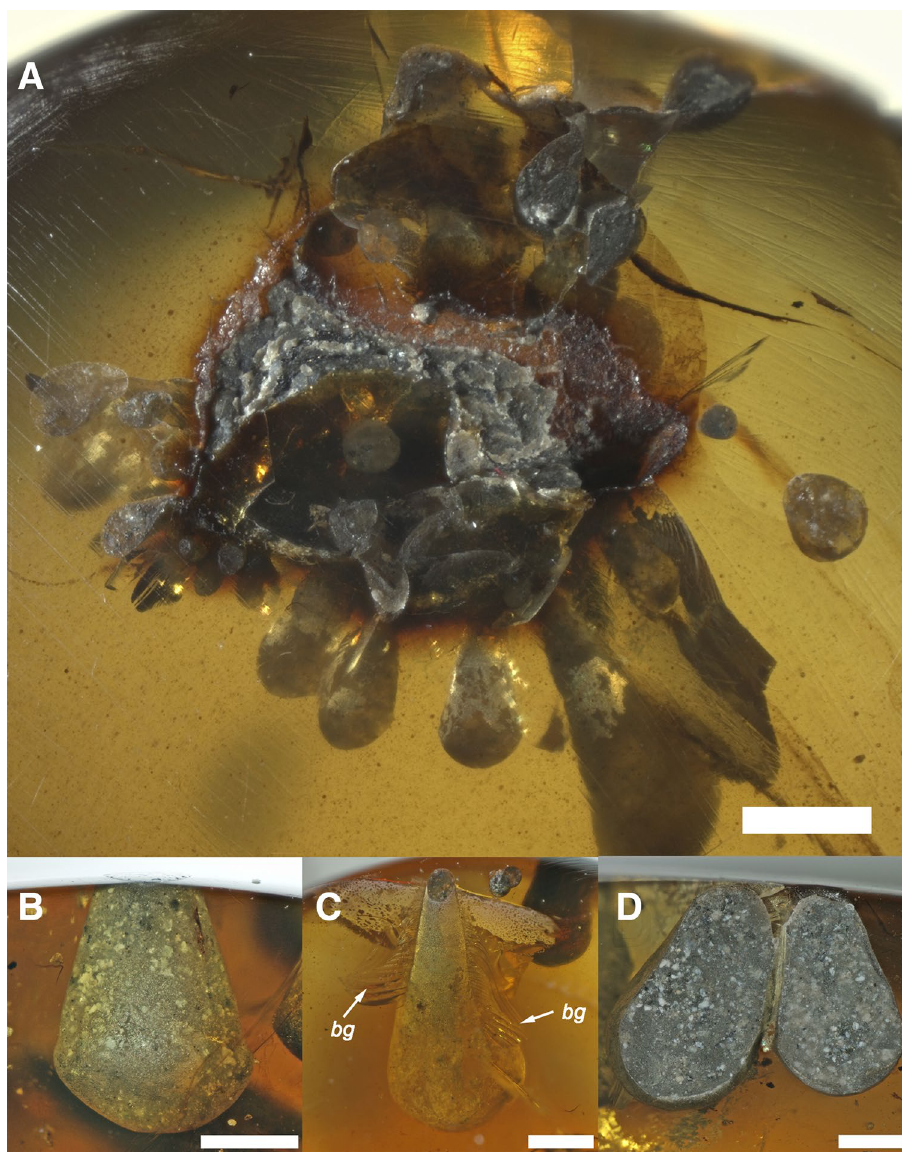
Figure 7. Clavate borings of † Palaeolignopholas kachinensis gen. & sp. nov. from lower Cenomanian Kachin amber, northern Myanmar. ( A ) Cluster of borings. It marks drilling of immature piddocks into soft resin from the unidentified plant (wood?) fragment. ( B–D ) Clavate borings of adult piddocks. Scale bars = 1 mm. Abbreviation: bg a characteristic bioglyph indicating the shell rotation inside hardening resin. (Photos: Ilya V.